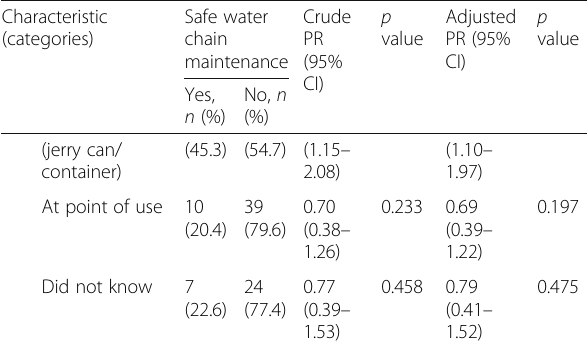
Table 6 Factors associated with maintenance of the safe water chain